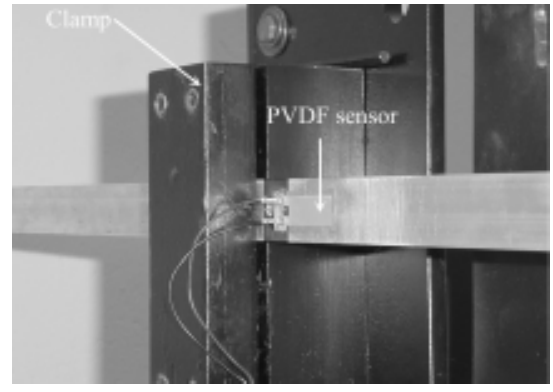
Fig. 5. Experimental apparatus.